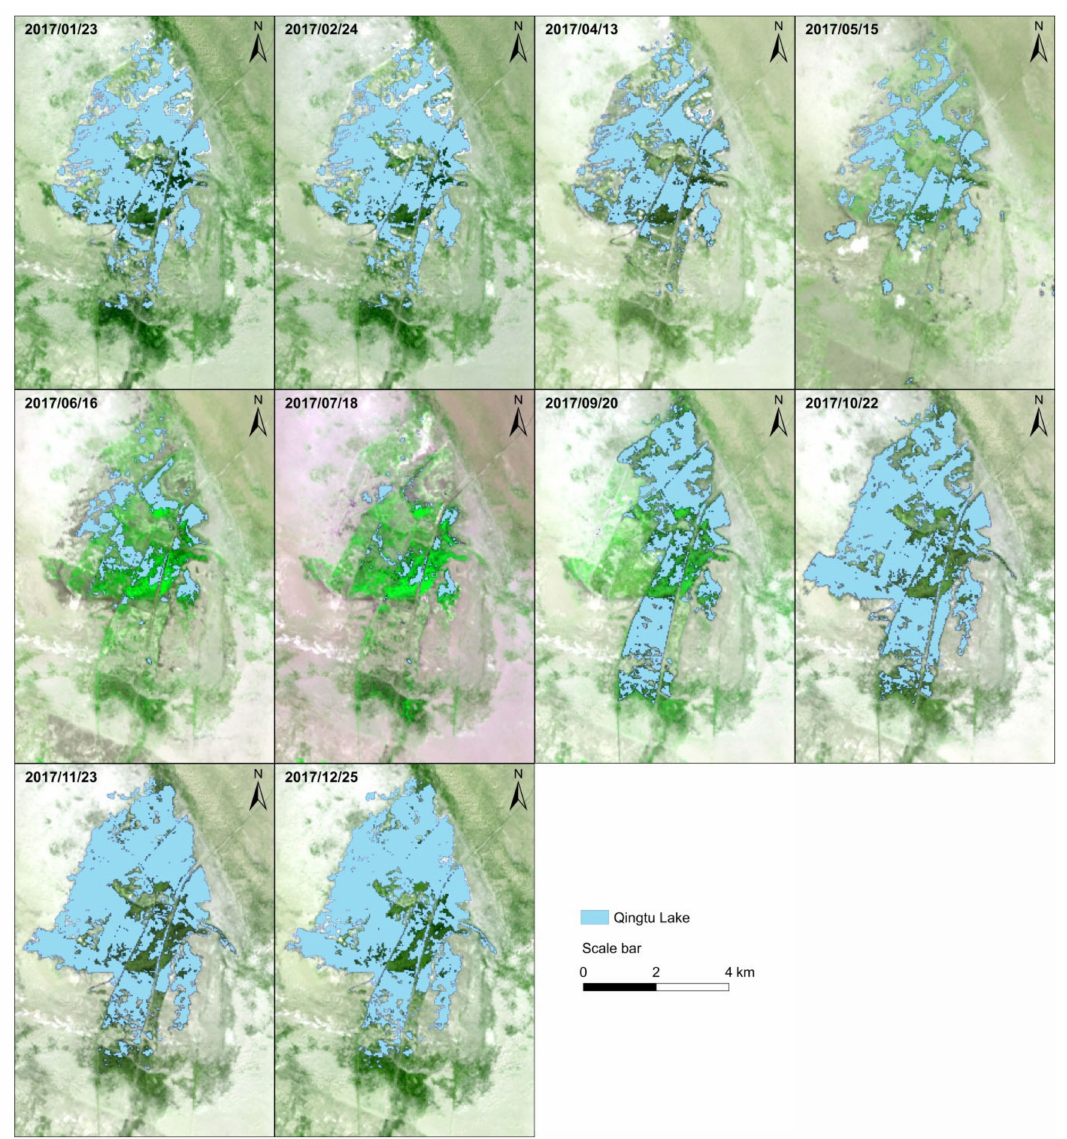
Figure 4. Spatial distribution of the Qingtu Lake water body from January to December 2017. The spatial trend of the lake water body distribution was similar in other years after